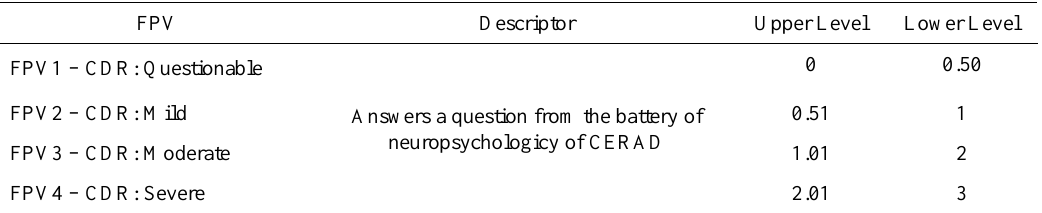
Table 4. Summary table of descriptors and impacts according to each